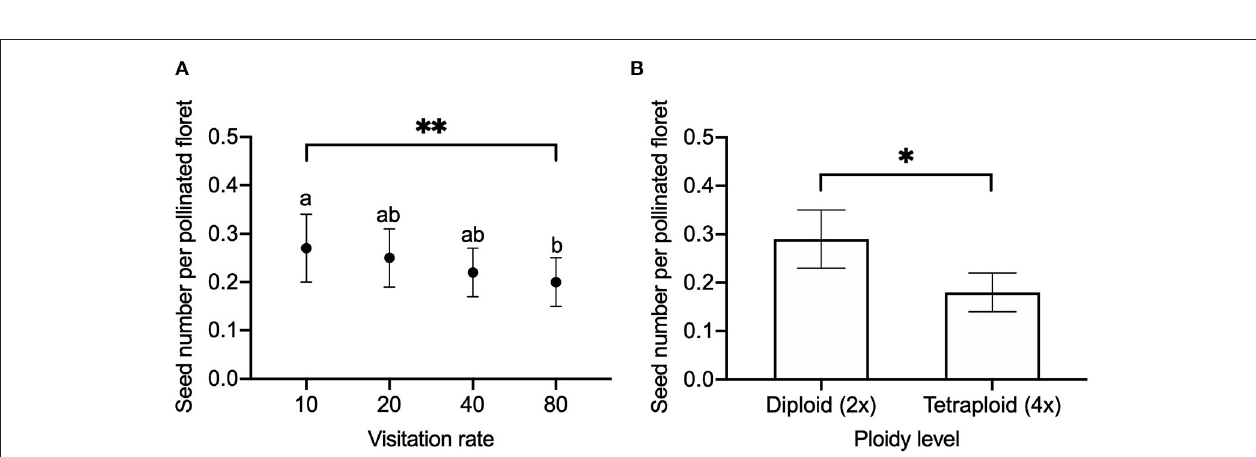
FIGURE 2 | Comparison of seed number per flower head in red clover under (A) different visitation rates (10, 20, 40, and 80 pollinated florets per flower head) and (B) comparison between diploid and tetraploid in hand pollination. Error bars indicate the 95% confidence interval of the estimated marginal means (EMMs). EMMs sharing a lowercase letter within the same figure are not significantly different at 0.05 significance level. ** P value = 0.0090; *** P- value < 0.0001.